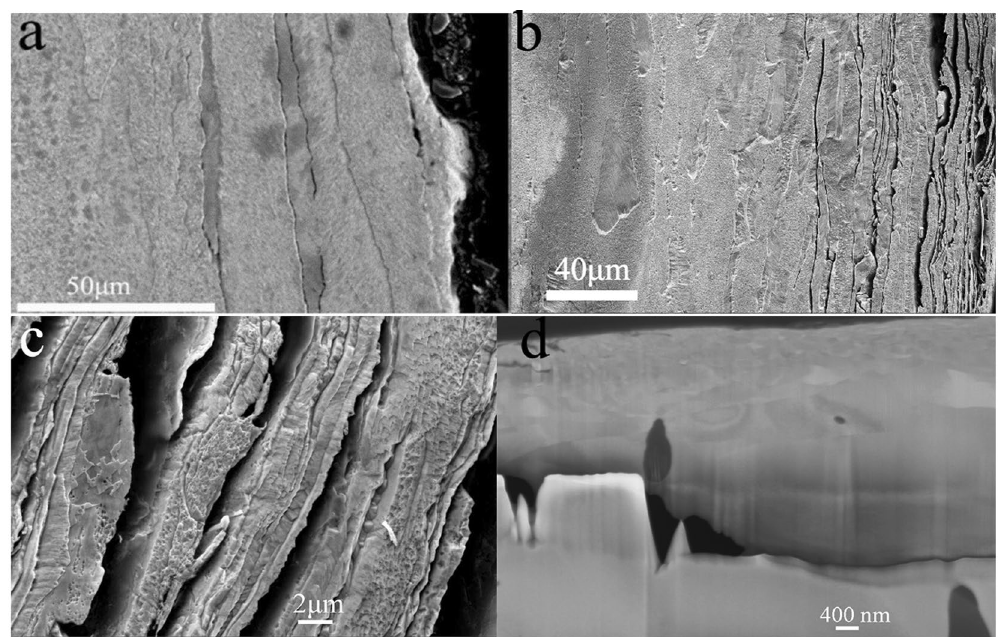
Figure 6. Cross sectional profile of WL10. ( a ) Untreated commercial WL10, ( b ) ϕ 1.5 mm ZrO 2 ball SMATed laminates observed near the surface, ( c ) enlarged SEM image of laminates in ( b ), and ( d ) cross sectional nanostructured surface layer taken from the FIB